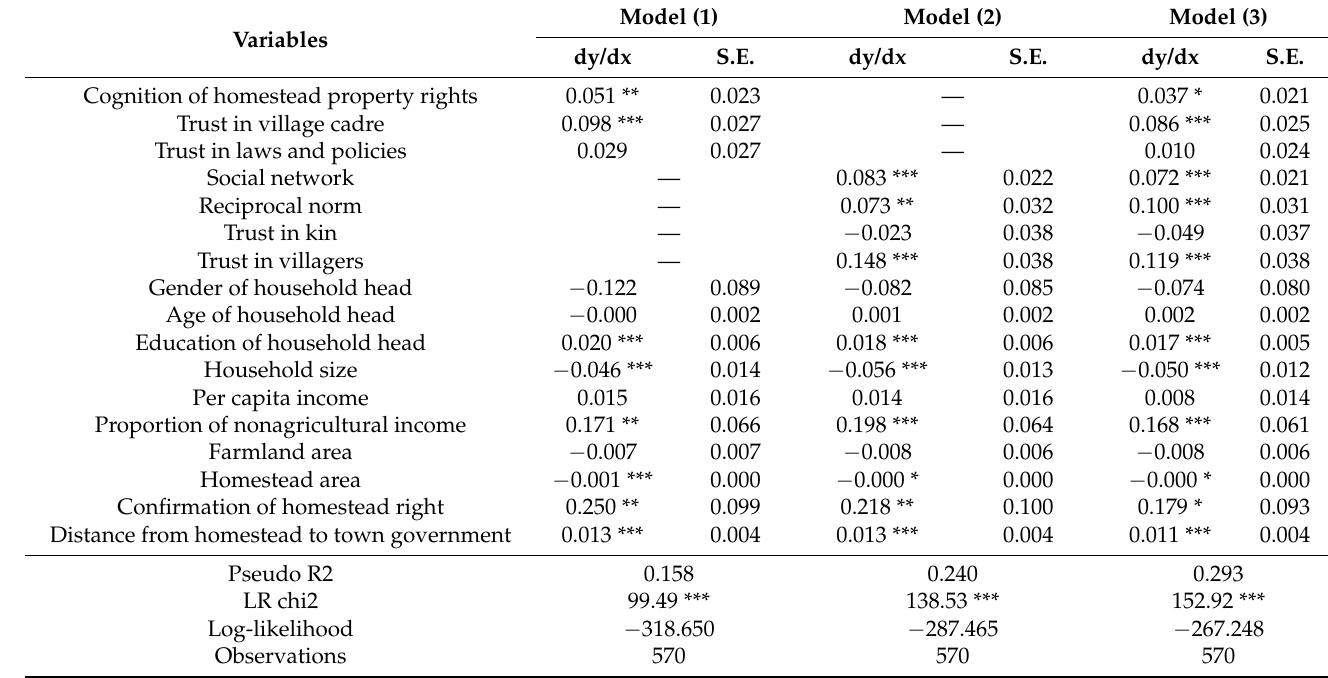
Table 3. Results of the effect of formal institutions and informal institutions on farmers’ behavior to WRH.